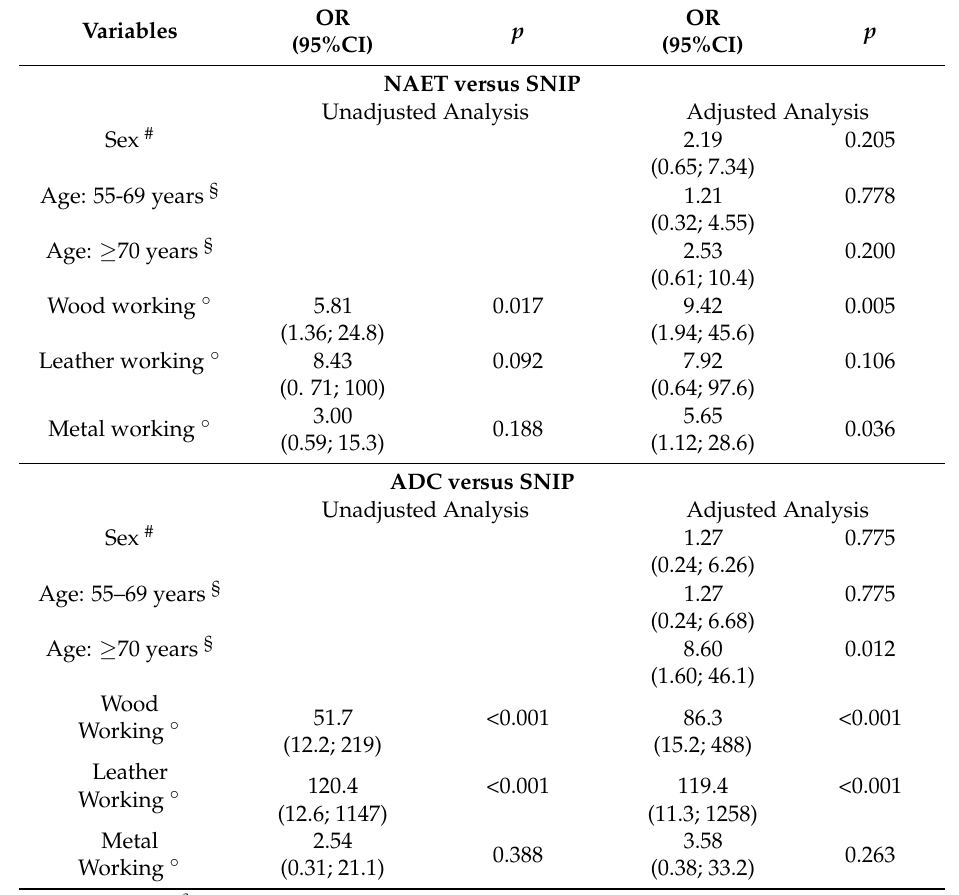
Table 2. Multinomial logistic regression estimating the odds ratio (OR) with a 95% confidence interval (95%CI) and two-tailed p -value ( p ) for a categorical dependent variable taking the value 0 for sinonasal inverted papilloma (SNIP), 1 for non-adenocarcinoma epithelial tumors (NAET) and 2 for adenocarcinoma (ADC). Unadjusted and age–sex adjusted risk estimates in each